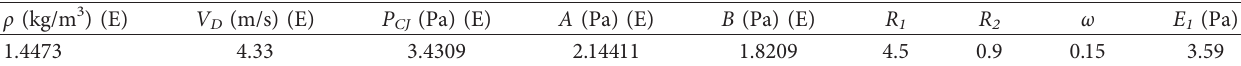
Figure 2: Position of the reference Table 1: Parameters of TNT.